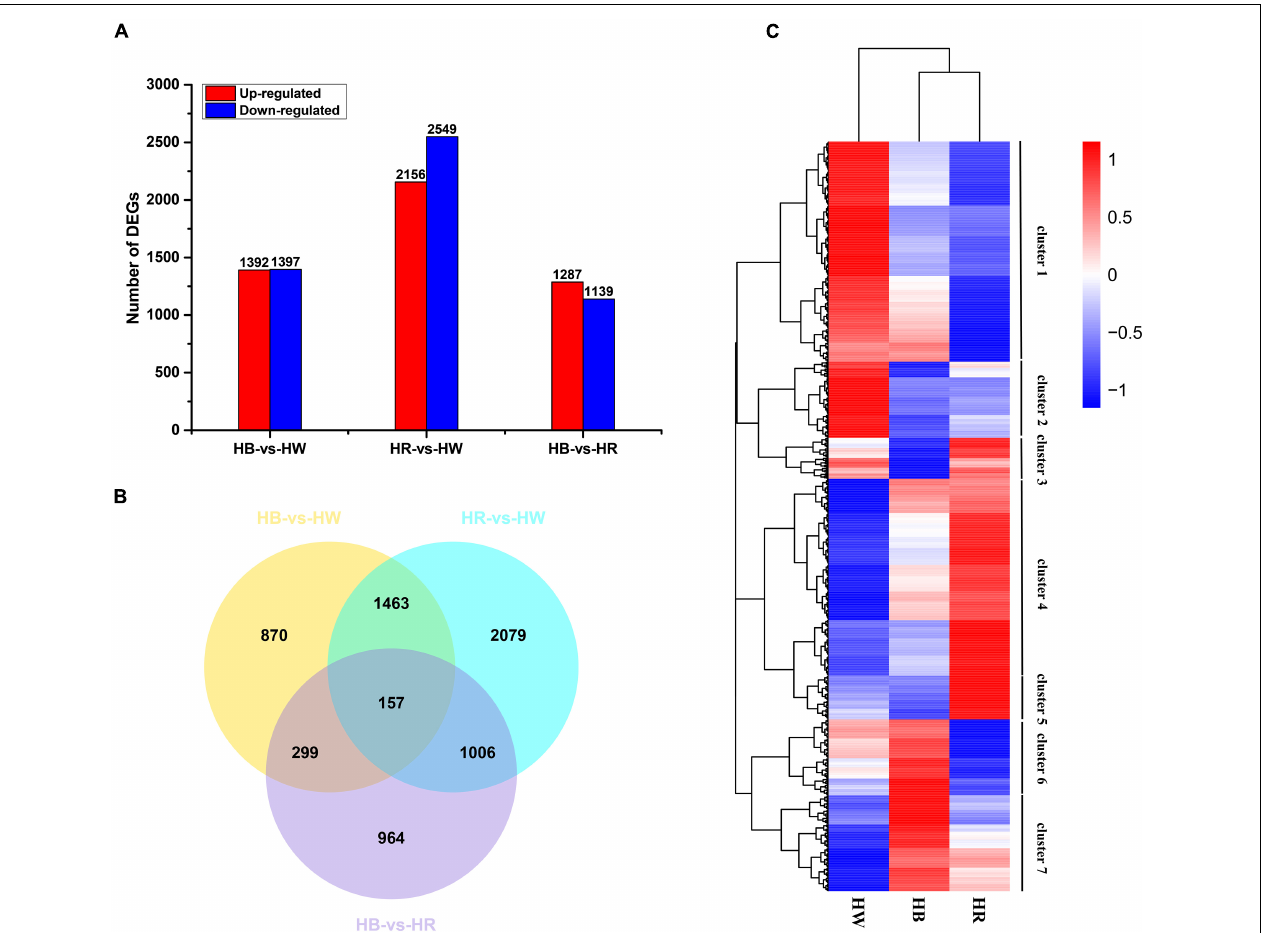
FIGURE 3 | Differential gene expression induced by red or blue light. (A) Numbers of DEGs in pairwise comparisons of the three libraries. (B) Venn diagram showing DEG distributions. (C) Expression profile clustering. The color scale at the right represents re-processed log10 (FPKM + 1) using heatmap, representing the relative expression level. The expression variance for each gene is indicated by different colors ranging from low (blue) to high (red). HW, HR, and HB indicates samples treated by white light, red light, and blue light,